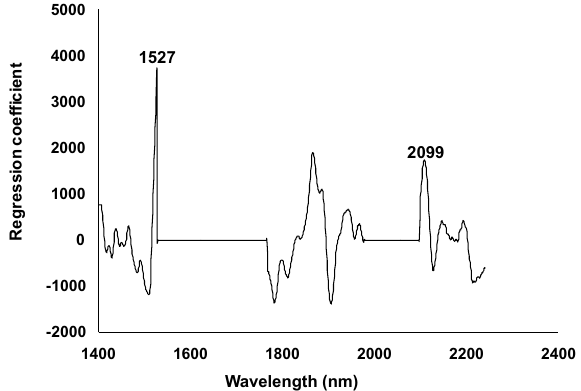
Fig. 4. The PLS model coe±cients of model developed for predicting setback of paddy rice in wavelength range of 1400 – 2400 nm.